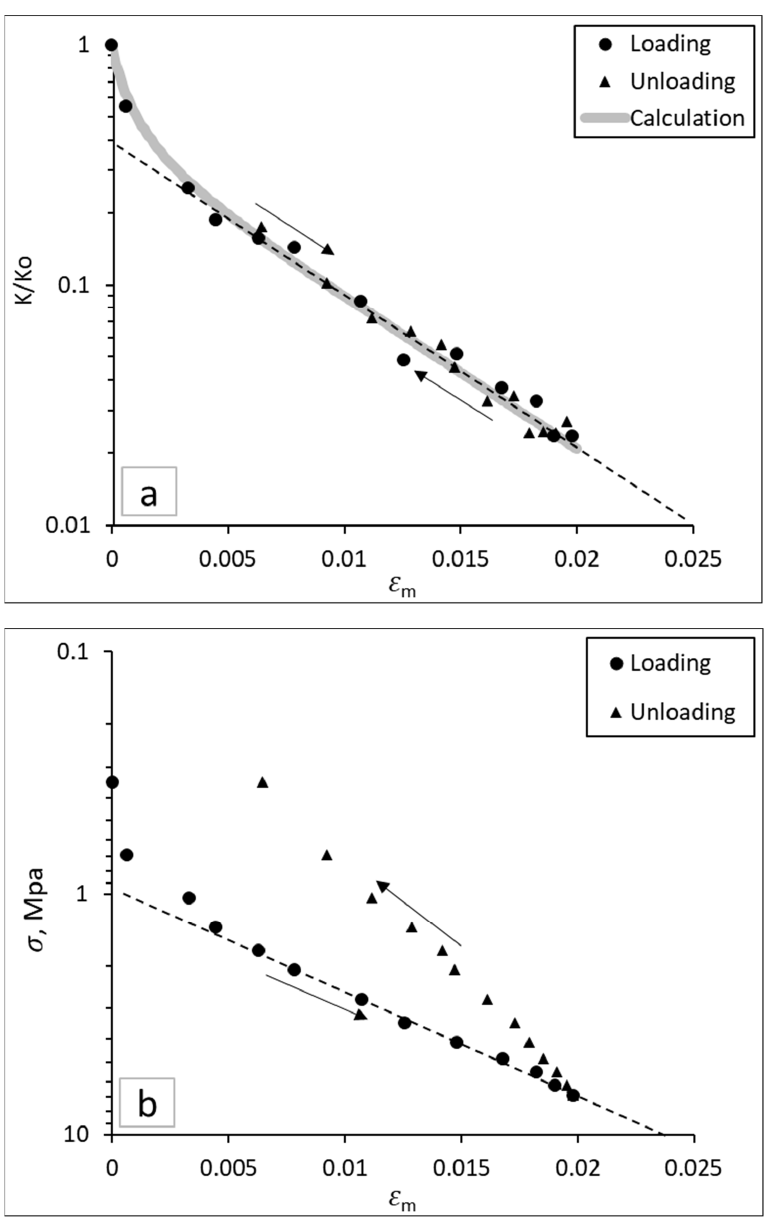
Figure 22. Permeability and strain of coal sample 3 (test 3).